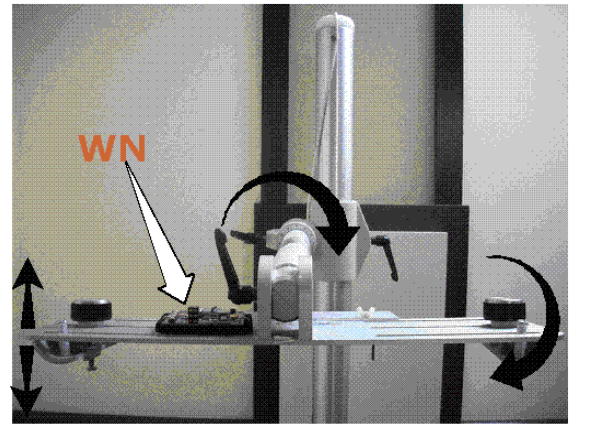
Figure 6. The wireless accelerometer was mounted on the Flexiholder from Huestis Medical.